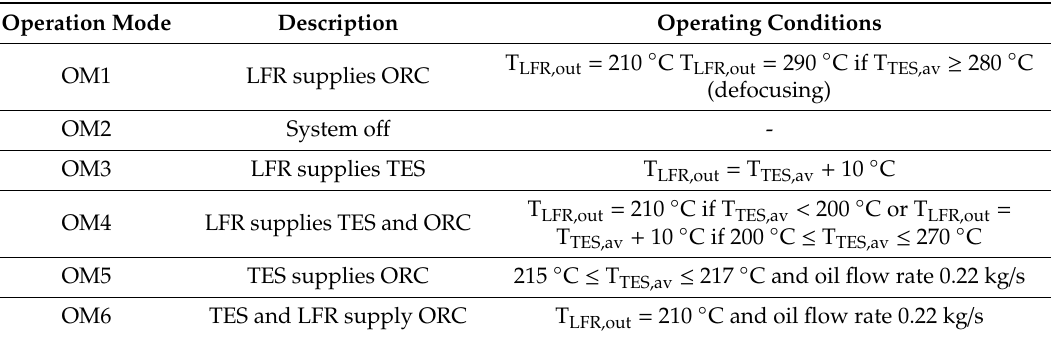
Table 1. Operating conditions for the different operation modes of the plant.